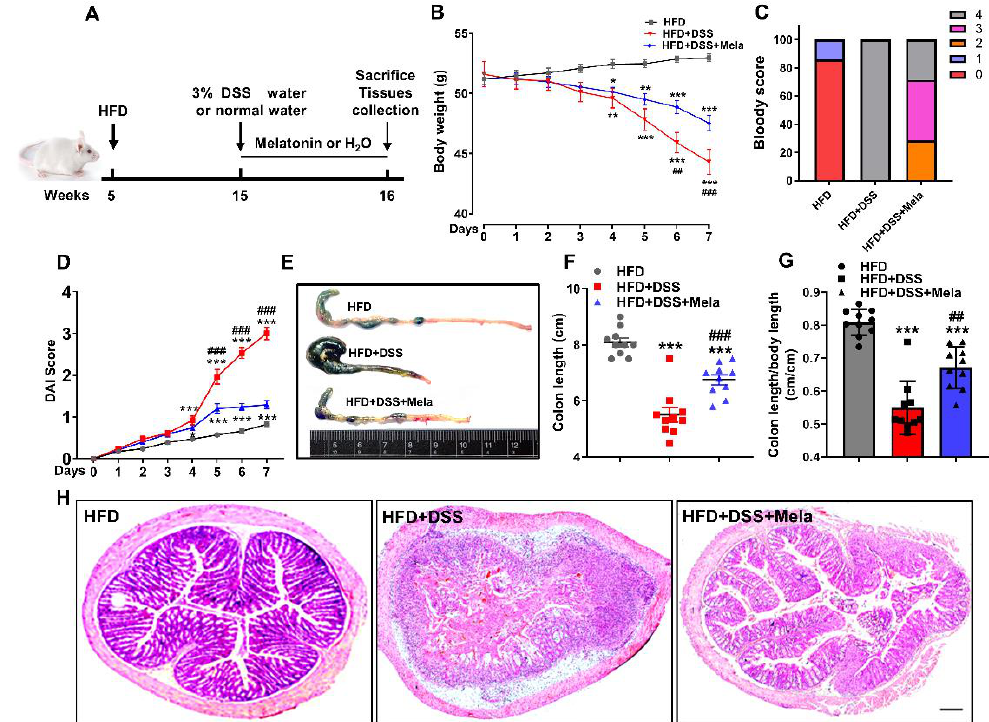
Figure 2. Melatonin alleviates DSS-induced colitis in obese mice. ( A ) Conceptual graph of the experimental procedure analyzing the effects of melatonin on DSS-induced colitis in obese mice. Male CD1 obese mice were treated daily with water or 10 mg/kg/day melatonin by intragastric gavage for 7 days. Tissues were collected on day 7 for analysis. ( B ) Bodyweight. ( C )The gross bleeding was evaluated on day 7. ( D ) The DAI score was assessed every day after DSS water supplementation. ( E ) Representative images of the colon’s appearance. ( F , G ) Statistical data of the colon length. ( H ) Representative images of histological damage in the colon with the indicated treatment. Scale bar = 200 µ m. Values are presented as the mean ± SEM. n = 10. * p < 0.05, ** p < 0.01, *** p < 0.001 compared with HFD; ## p < 0.01, ### p < 0.001 versus HFD + DSS.